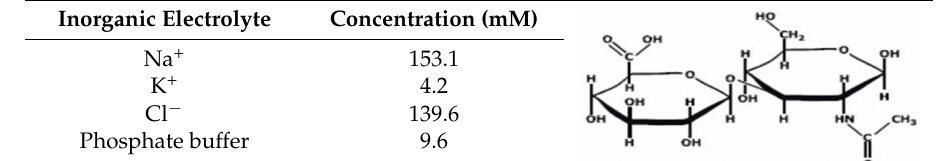
Table 1. Composition of simulated synovial fluid, Simulated Synovial Fluid (SSF) ( left ) and chemical formula of Hyaluronic acid (HA) ( right ). Inorganic Electrolyte Concentration (mM) Na + 153.1 K + 4.2 139.6